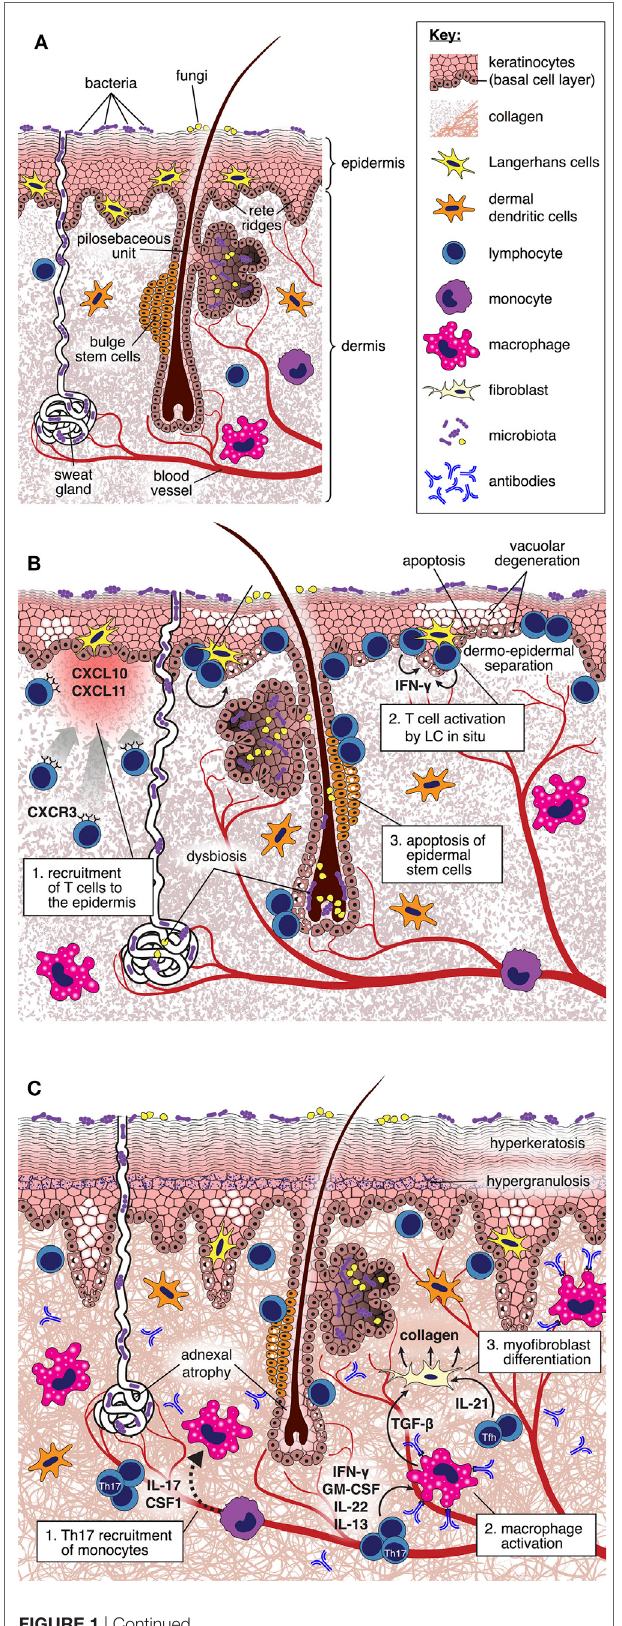
FiGURe 1 | Pathogenesis of cutaneous graft-versus-host disease (GVHD). (A) Diagram depicting cellular and structural elements of normal skin. (B) During acute GVHD, the local production of IFN- γ inducible chemokines in response to tissue injury promotes the recruitment of CXCR3 + alloreactive T cells into the skin (34). Upon in situ interaction with host-type Langerhans cells, alloreactive T cells are reprogramed to differentiate into pathogenic effector cells characterized by enhanced survival and generation of IFN- γ (35). Pathogenic T cells kill Lgr5 + epidermal stem cells (36), thus disabling normal repair mechanisms and epidermopoiesis; these effects are manifested by vacuolar degeneration and apoptosis of the basal and suprabasal epidermal cells, focal dermo-epidermal separation, and necrosis of the epidermis with denudation. Distortion of the local microbiome as a consequence of the conditioning regimen and antibiotic therapy may also be an important factor driving skin inflammation (37). (C) During the evolution of chronic GVHD, donor T cell-derived IL-17 is required for recruitment of Ly6C low monocytes to the skin, which then differentiate into macrophages (38). Generation of transforming growth factor (TGF)- β by activated macrophages induces fibroblasts to differentiate into myofibroblasts that promote collagen deposition through a heat shock protein 47-dependent mechanism (39). Binding of allo- or auto-antibodies to macrophage Fc receptors induces their polarization toward the M2 phenotype and production of TGF- β (27), thus amplifying the process of myofibroblast generation of collagen. IL-21 generation by follicular helper-like cells recruited to the skin may also have direct effects upon skin fibroblast differentiation (40). Collectively, these mechanisms lead to thickening and homogenization of collagen bundles throughout the